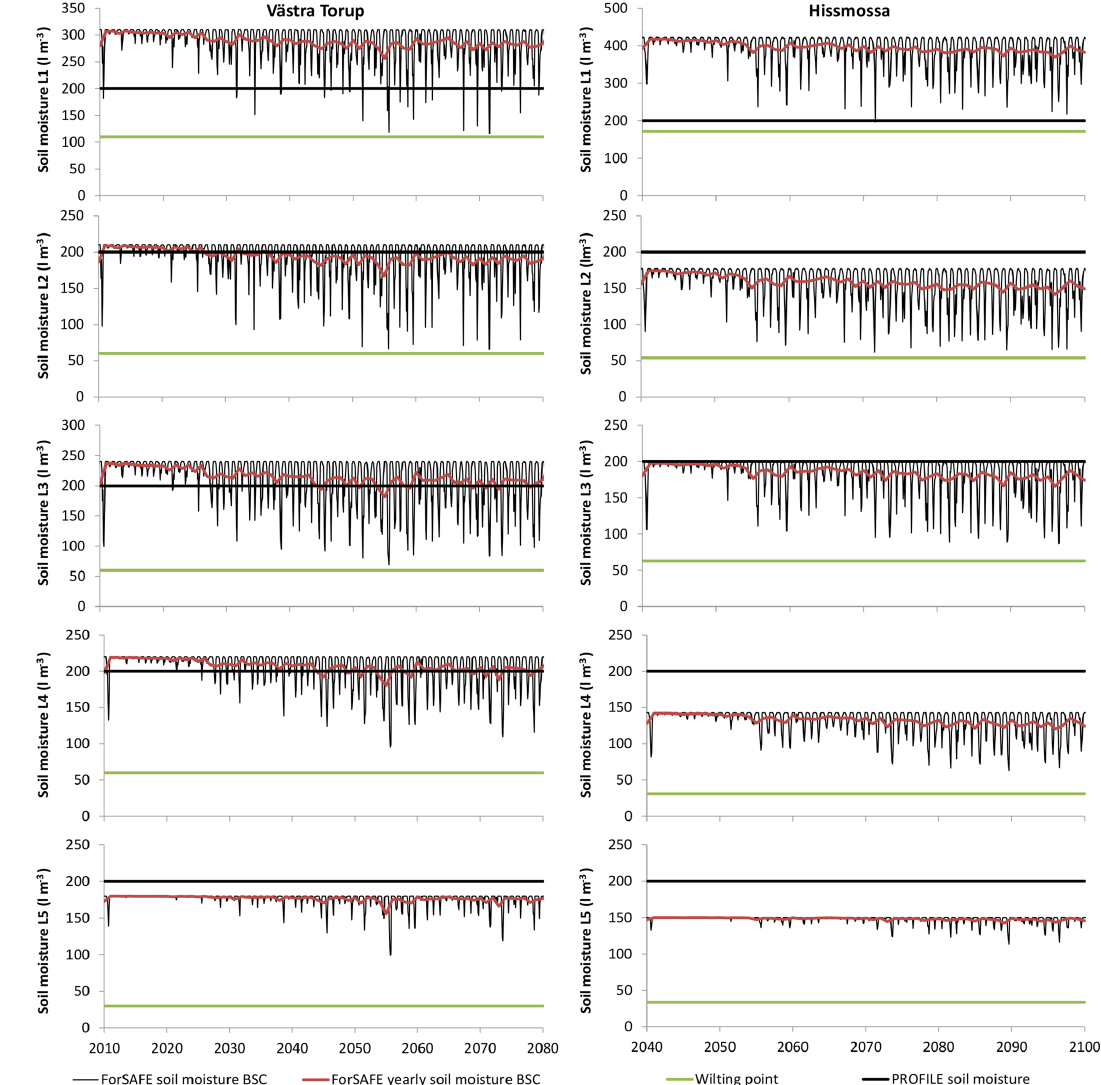
Figure 2. Soil moisture in all soil layers, BSC scenario, forest rotation 2010–2080 in Västra Torup and 2040–2100 in Hissmossa, compared to wilting-point and PROFILE-input soil